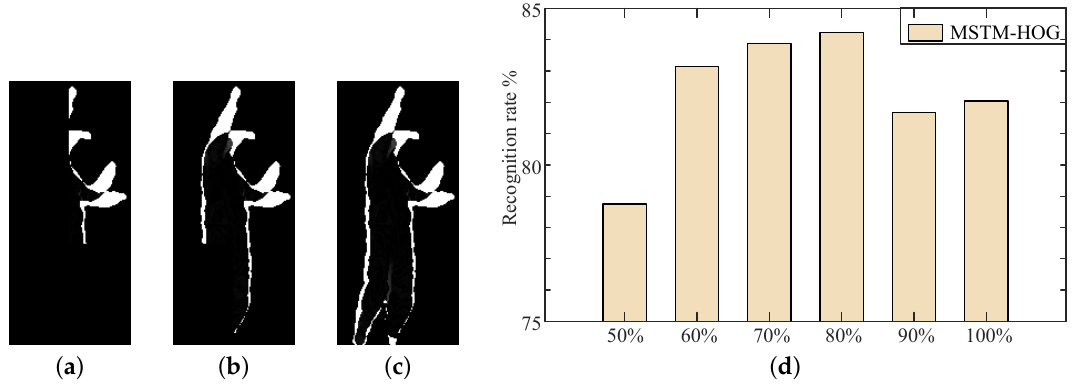
Figure 9. When setting different ξ , the effect of key motion energy retained. ( a ) ξ = 50%; ( b ) ξ = 80% ( c ) The original motion energy ( d ) The recognition result of MTSM-HOG when setting different ξ